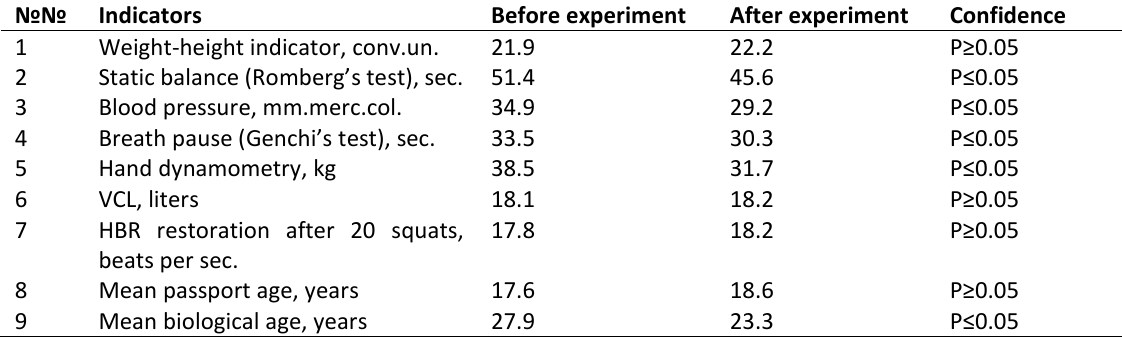
Table 1. Girls-students’ biological age indicators before and after application the authors’